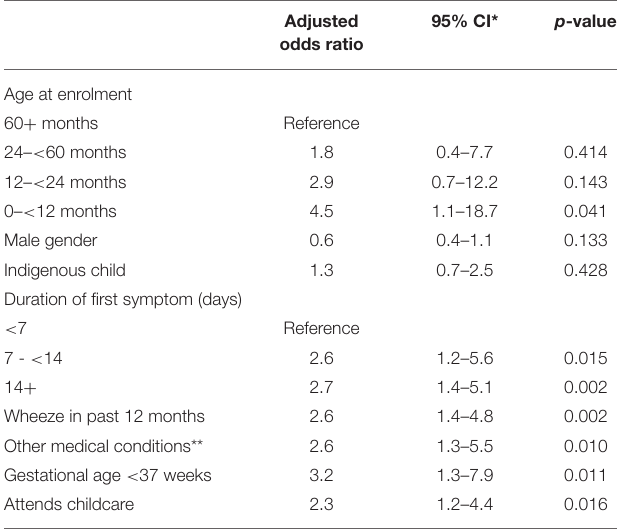
TABLE 3 | Predictors of chronic cough at day-28 in childcare attendees, excluding and including children with unknown cough status. Adjusted 95% CI* p odds ratio